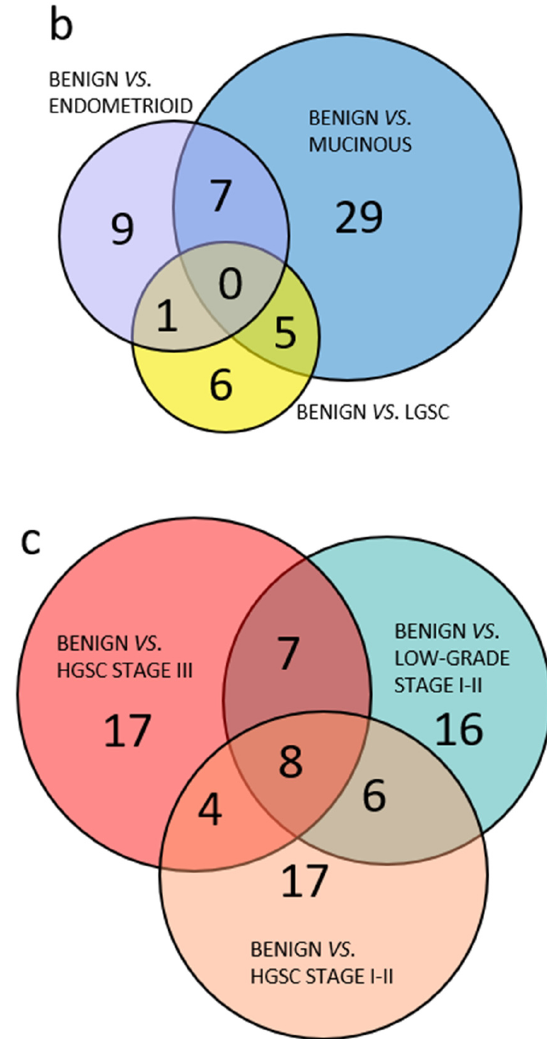
Figure 2. Venn diagram of benign and OC subgroups with number of overlapping peptides with p < 0.05 ( t -test). ( a ) Benign vs. less common low-grade OC including borderline type tumors compared to benign vs. high-grade OC; ( b ) comparison of benign vs. OC low-grade subgroups; ( c ) comparison of benign vs. all included low-grade OC, HGSC stage I–II or HGSC stage III. 3.1.2. Multivariate Analysis of Benign Versus Malignant Tumors. Table 2. Overview of comparisons of benign vs. malignant subgroups including borderline type tumors. Benign vs. Subgroup